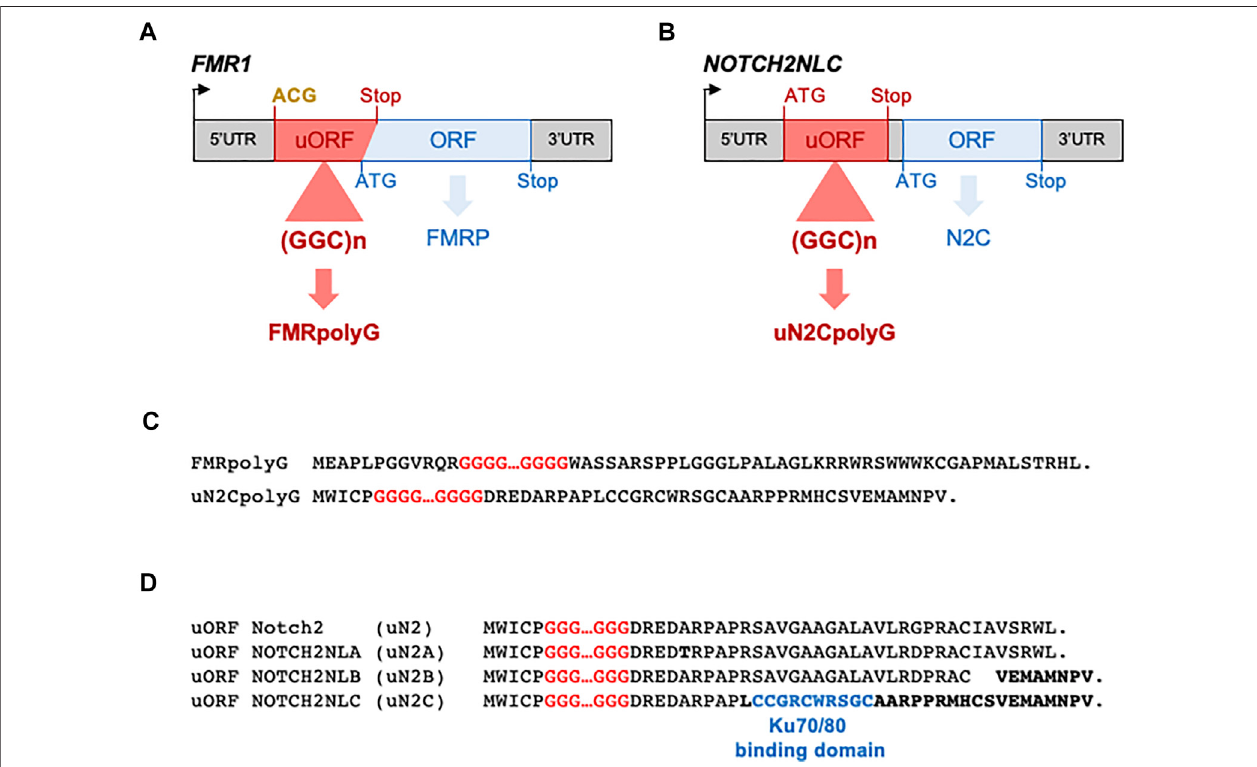
FIGURE 2 | CGG repeat expansions are translated into polyG proteins in FXTAS and NIID. (A) Scheme of FMR1 indicating FMRpolyG upstream ORF and FMRP mainORFlocalization. (B) SchemeofNOTCH2NLC indicating uN2CpolyG upstream ORFandNOTCH2NLC(abbreviated N2C)mainORFlocalization.Initiationcodons and stop codons are indicated in red for uORFs and in blue for the main ORFs. Near-cognate initiations codons are indicated in bold yellow. (C) Protein sequences of FMRpolyGanduN2CpolyGshownosimilitude beyondtheirpolyglycinestretch. (D) SequencesoftheputativeuORFsembeddedwithinNOTCH2, NOTCHNLA, B and C 5 ′ UTRs. Variant amino acids are indicated in bold. The sequence required for uN2C to interact with KU70/KU80 is indicated in blue.